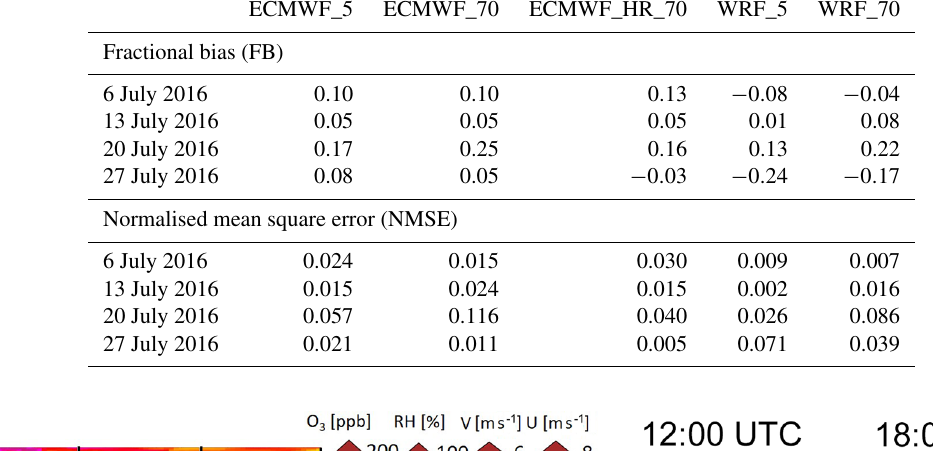
Table 4. FB and NMSE of the comparisons between LOTOS-EUROS simulations of vertical profiles of O 3 and data from four O 3 soundings performed in Madrid in July 2016.